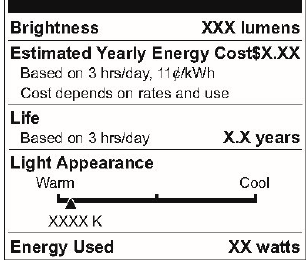
Figure 2. Lighting facts [15].